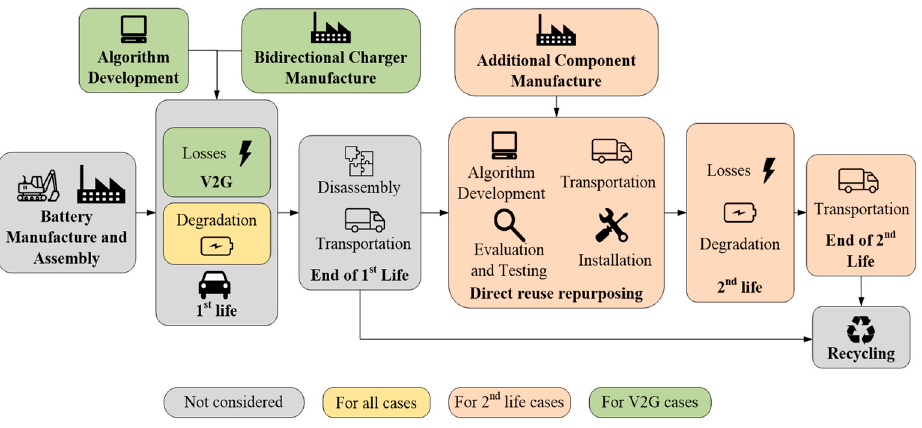
Figure 1. Lifecycle of the EV battery.